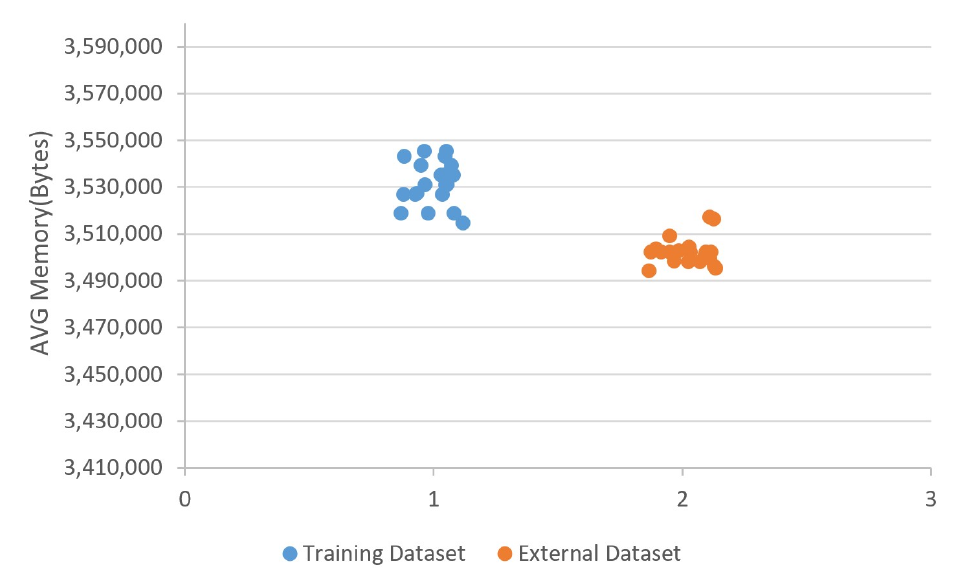
Figure 5. Scatter chart of average memory consumed by the sysbench_memory benchmark on different hardware configuration